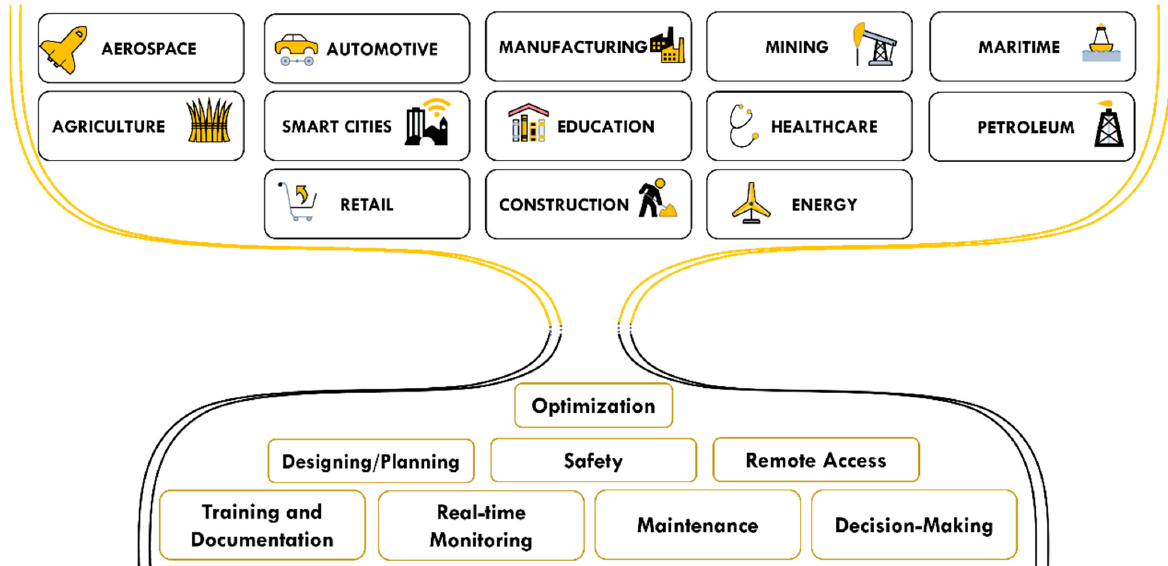
Figure 6. Applications of DTs in different sectors.